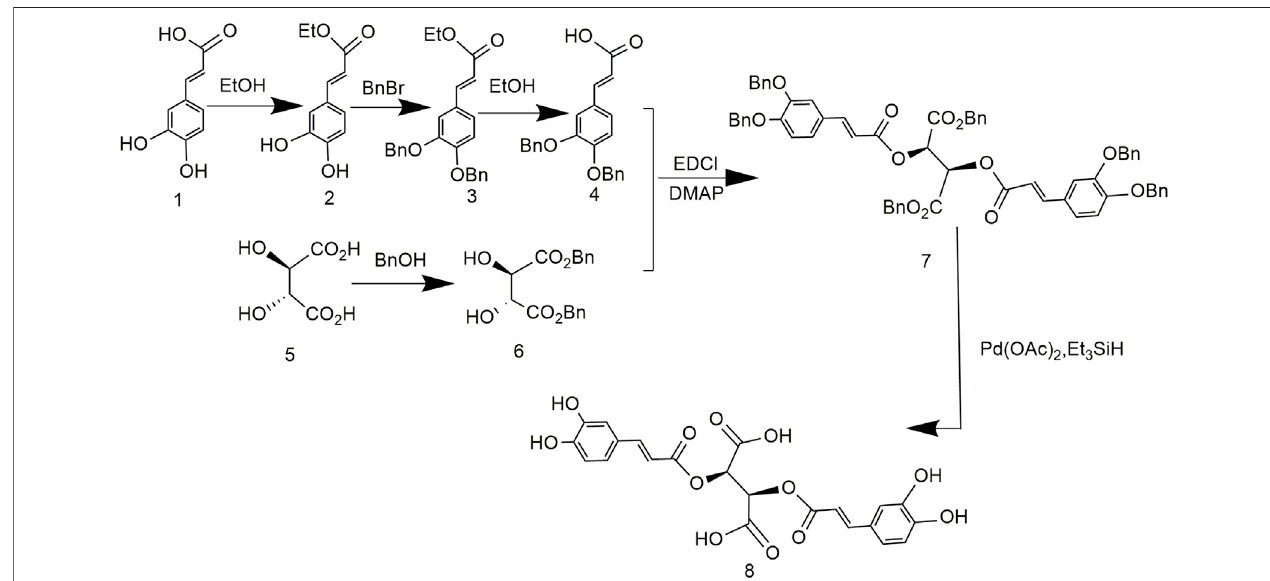
FIGURE 6 | Chemical synthesis pathway 4 of chicoric acid.